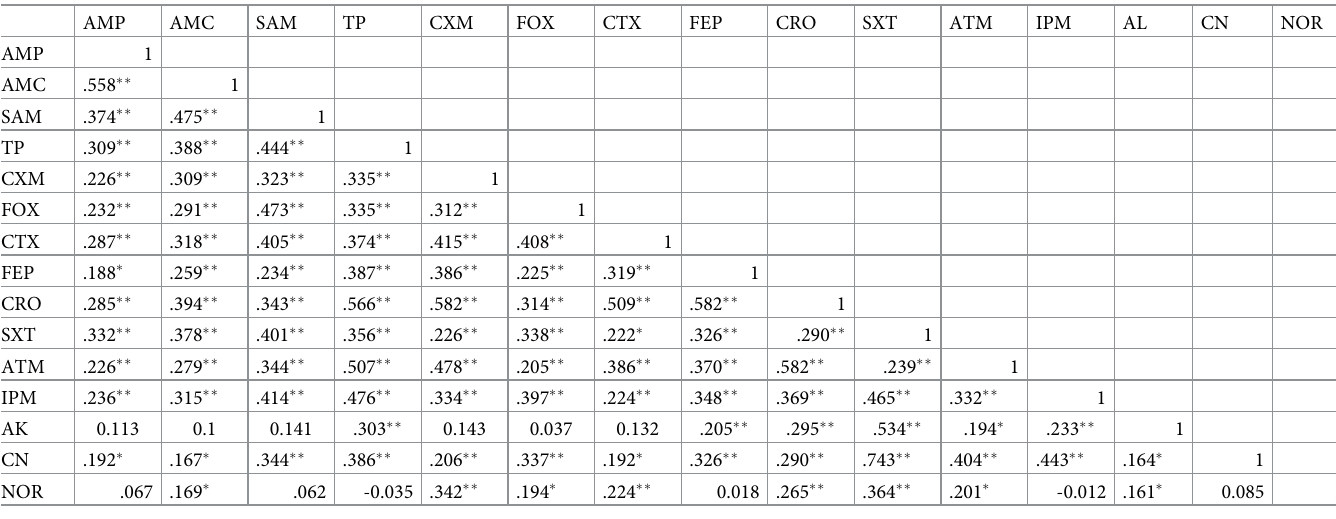
Table 7. The correlation between the tested antimicrobial agents. AMP AMC SAM